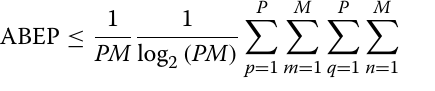
As far as the statistical distributions of β k , θ k , and φ k as concerned, Table 1 summarizes the most commonly used models. In particular, θ k is often modeled as a truncated Laplacian random variable, and φ k is often modeled as a Von-Mises, truncated Gaussian, or an uniform random variable. For each ray, the random variables are assumed to be independent and identically distributed.